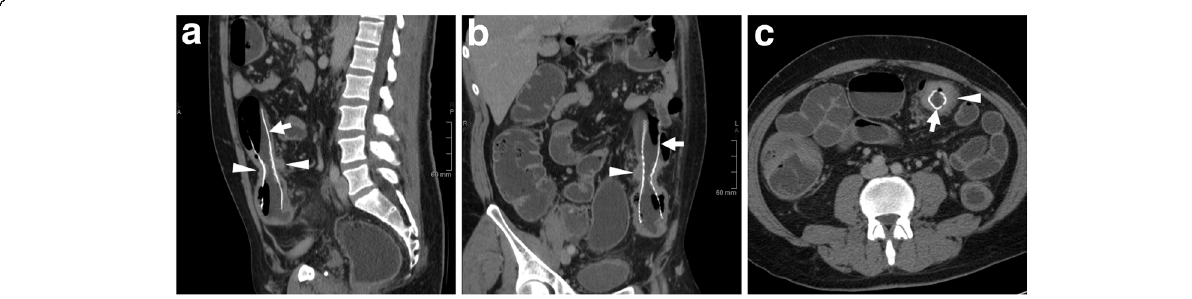
Fig. 5 Comprehensive staging of SEMS-treated CRC using water enema CT. Multiplanar contrast-enhanced images ( a – c ) show sufficiently